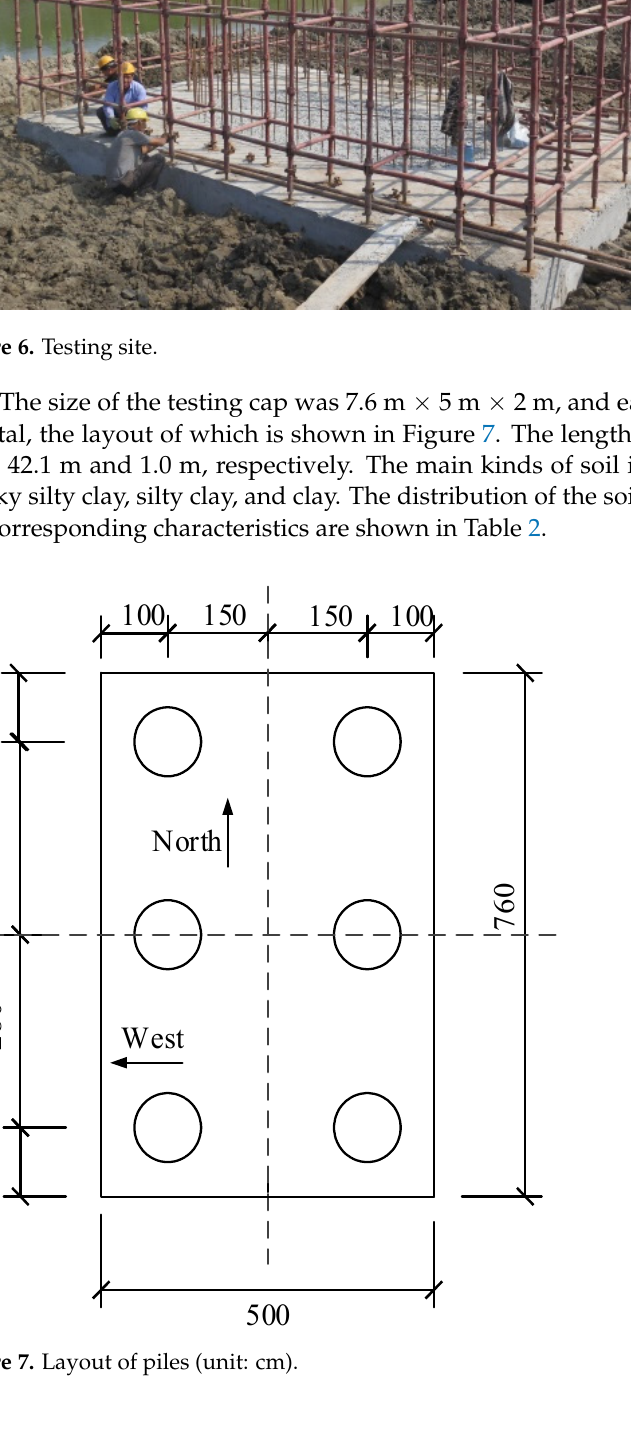
Table 2. Parameters of the 2 × 3 pile-group foundation.